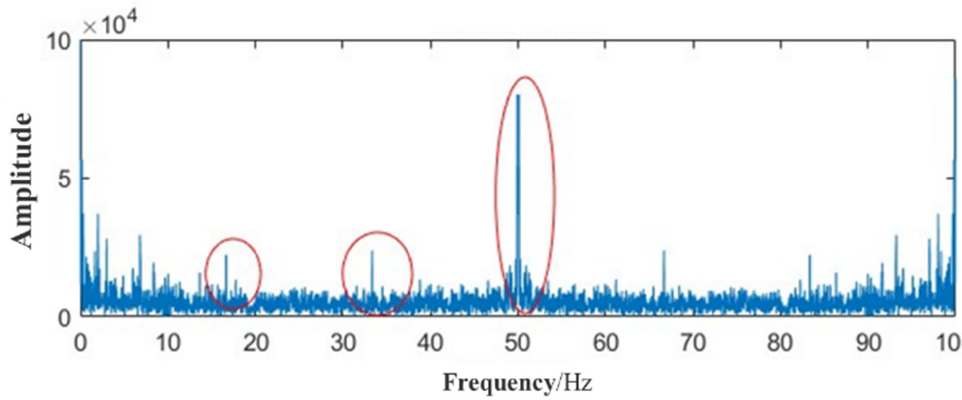
Figure 6. Full-wave spectrum diagram of sensor signals in drilling system. The noise signals of the sensor all have peak values at about 0~10 Hz, and large peak values at about 18 Hz, 34 Hz, and 50 Hz (the red circles). According to the results in the figure, it is appropriate to select 15 Hz as the cutoff frequency filter.